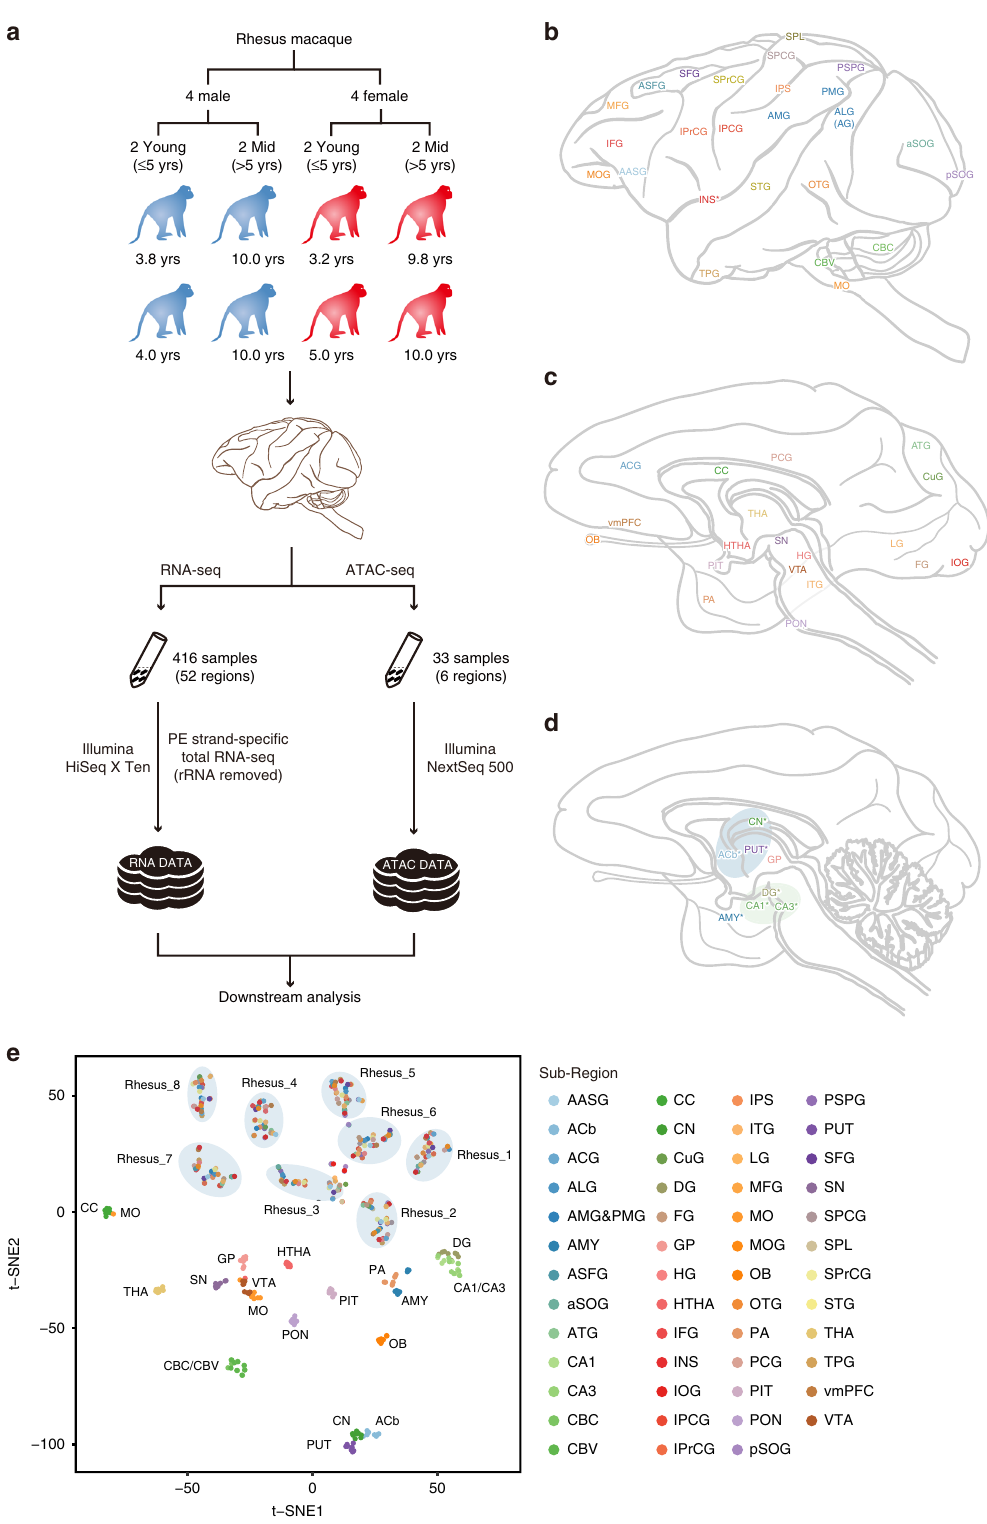
Fig. 1 Experimental protocol, diagram of the macaque brain. a Diagram of experimental design. b Lateral surface of the rhesus macaque brain, marked with name of brain regions. Full names for the abbreviations of the brain regions were listed in Table S1. c , d Median sagittal plane view of the rhesus macaque brain. e t-SNE scatterplot of various brain regions based on the whole-genome transcriptome, and the dot color represented its origin of region. The shadow circles showed clusters of cortex regions from each rhesus macaque